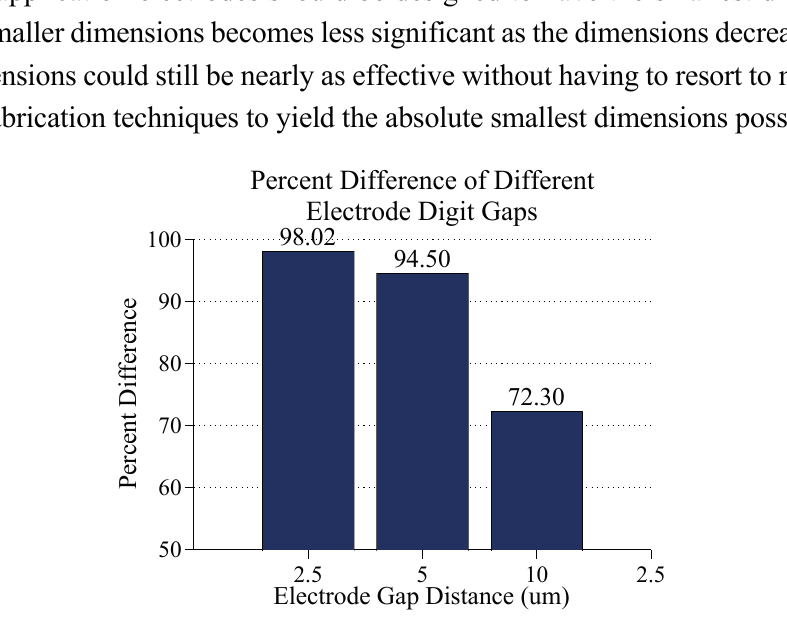
Figure 10. The percent difference in the electric field magnitude at the center of the gap between electrodes digits with and without 60 nm GNPs bound to the surface of the electrodes with varying electrode dimensions. GNPs are 20 nm above electrodes, 10 mM KCl concentration and 0.1 V DC applied to the